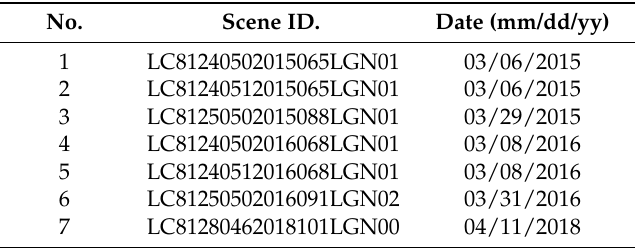
Table 2. Landsat images used to calculate SMC in this study. No. Scene ID.